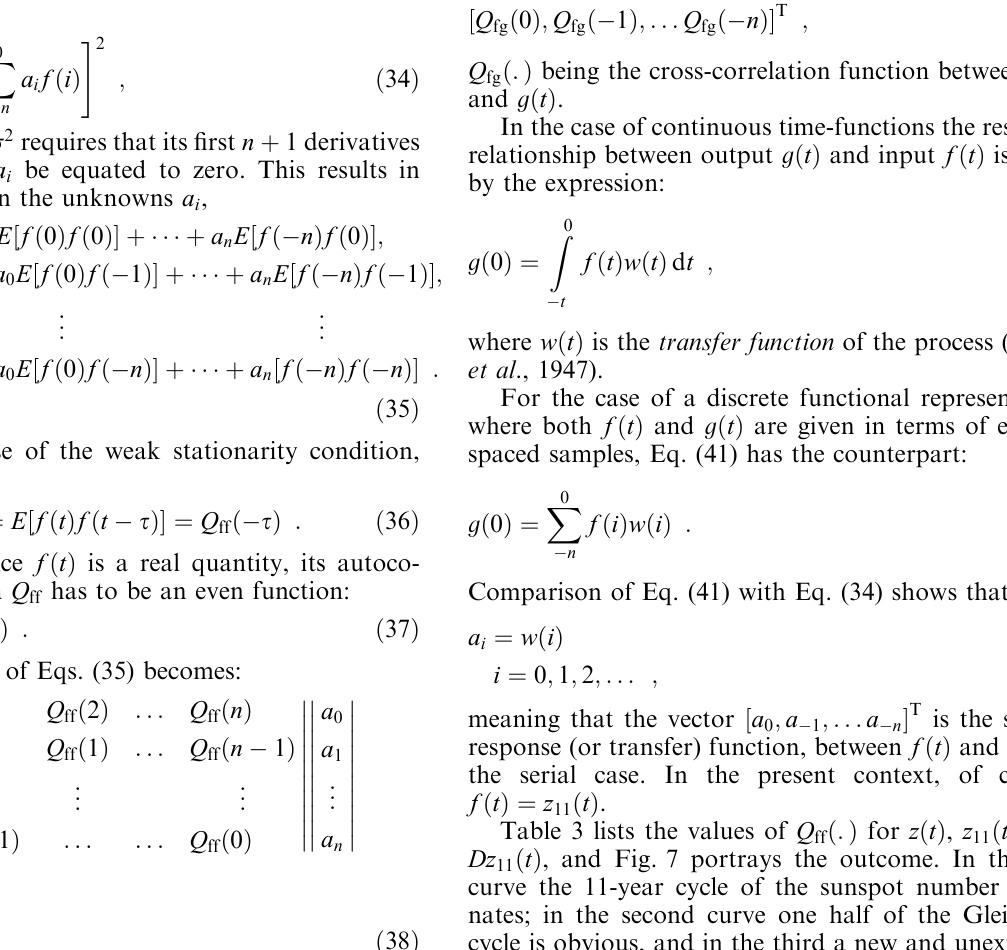
curve the 11-year cycle of the sunspot number domi- nates; in the second curve one half of the Gleissberg cycle is obvious, and in the third a new and unexpected